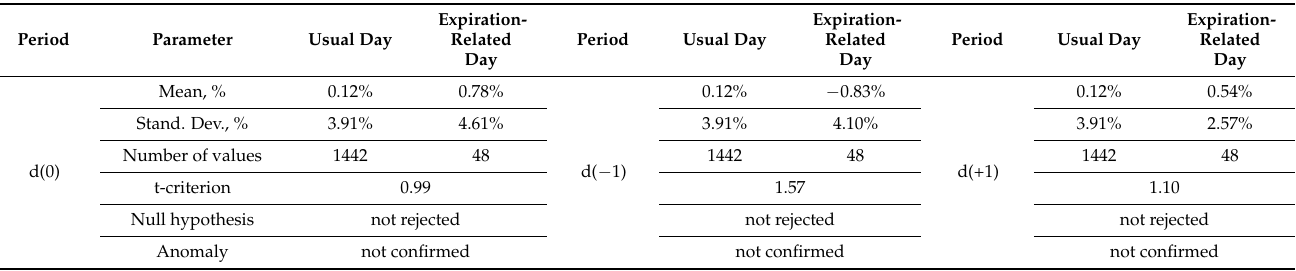
Table A4. T-test of the expiration day price effects.